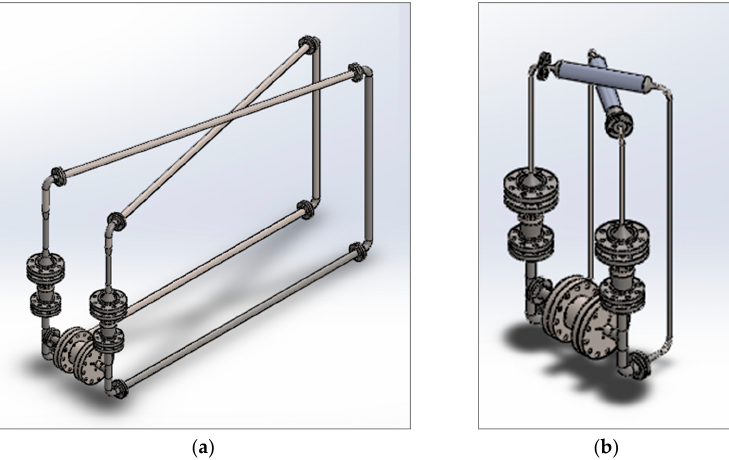
Figure 18. Electricity generator with: ( a ) original feedback loop and ( b ) improved feedback loop.